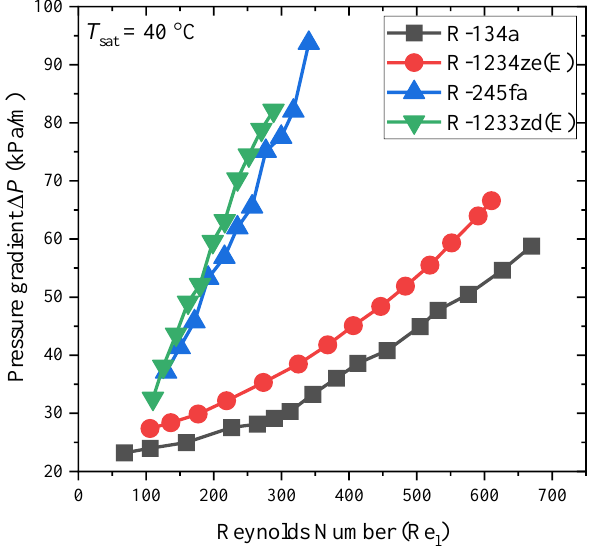
Figure 15. Comparative pressure gradients of R-134a, R-1234ze(E), R-1233zd(E), and R-245fa inside the plate heat exchanger (Zhang et al. [70]).